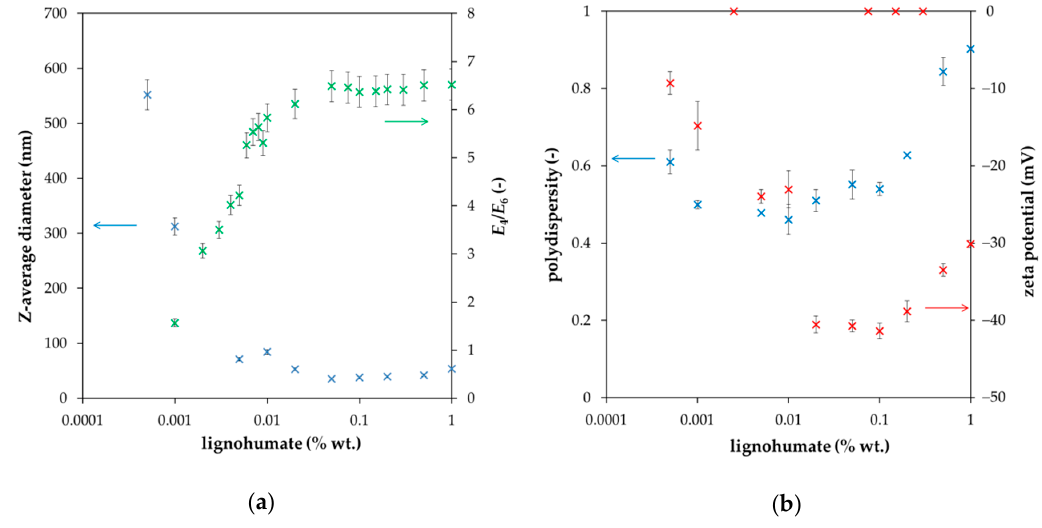
Figure 4. Z-average diameter and E 4 / E 6 ratio ( a ); polydispersity and zeta potential of lignohumate in the dependence on its concentration in aqueous solution ( b ).